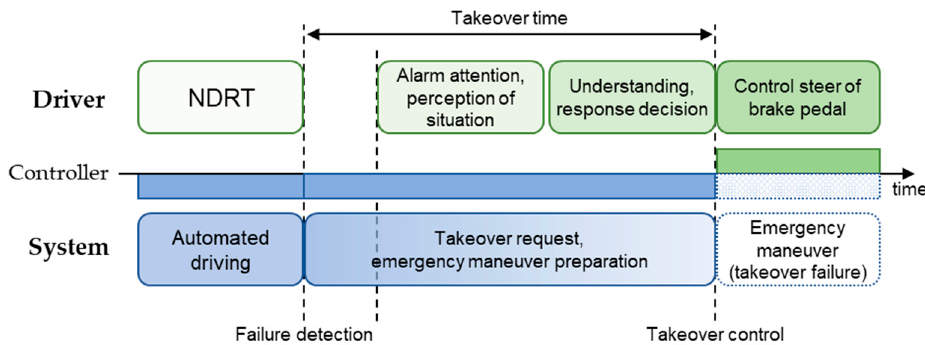
Figure 2. Takeover process [17]